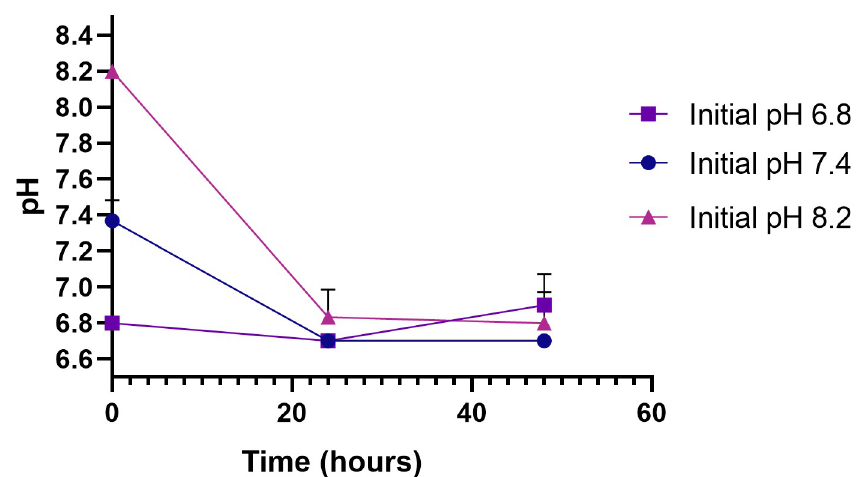
Fig 2. pH during culture. pH over 48-hour Cultures of N . gonorrhoeae ATCC 49226.